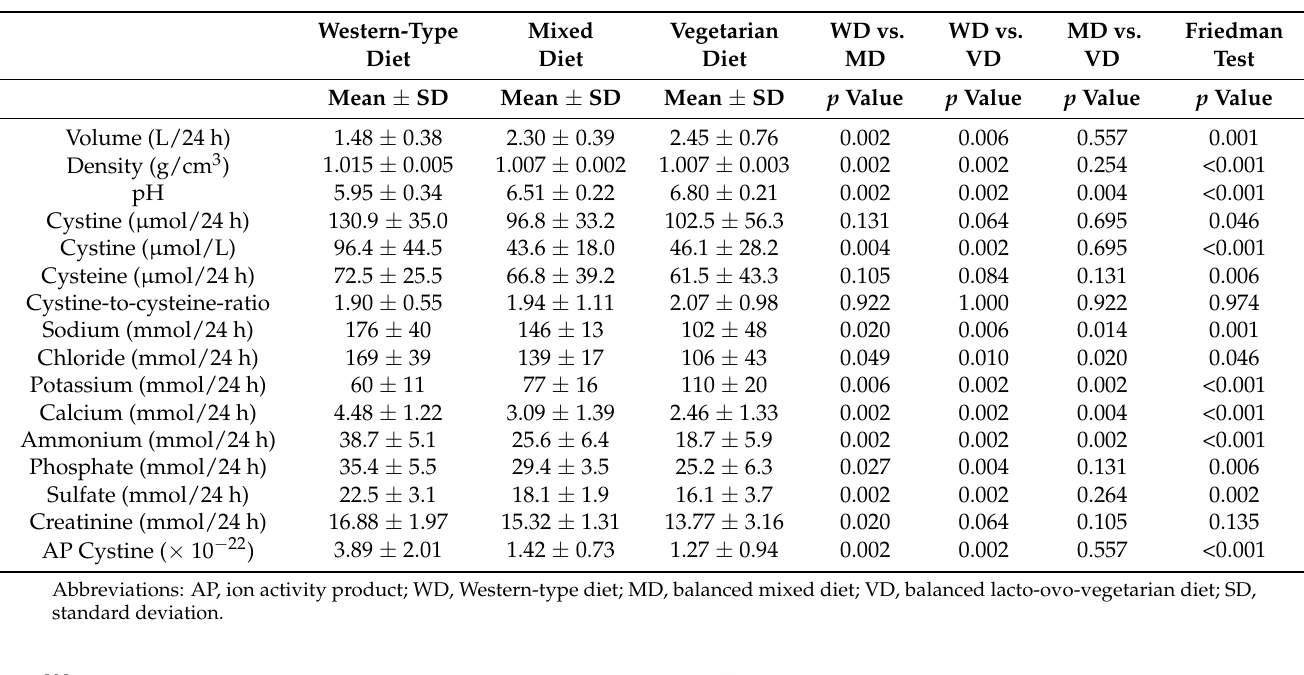
Table 2. Urinary parameters on the standardized Western-type, balanced mixed, and lacto-ovo-vegetarian diet ( n = 10).